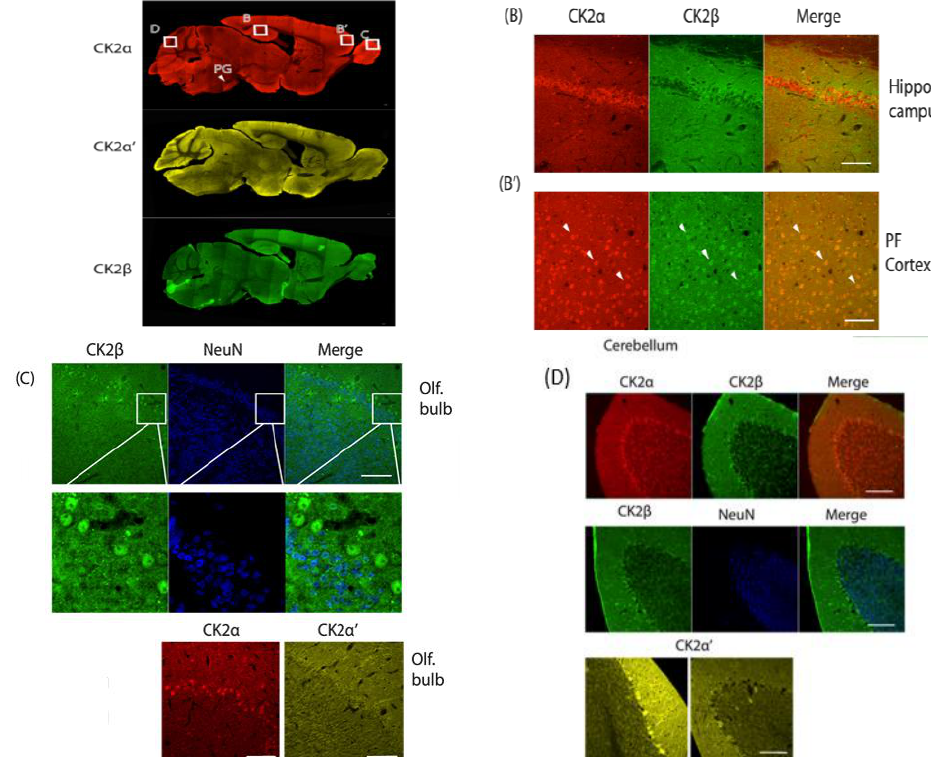
Figure 1. A–D: Immunohistochemical analysis of sagittal brain slices of adult C57BL/6 mice. PFA perfused brains were sliced (40 µm) and incubated with α-CK2α, α-CK2α’ (both Abcam), α-CK2β (gift from Dr. O. Filhol Grenoble) and α-NeuN (Cell Signaling) followed by incubation with secondary antibodies, Alexa 546/488 α-rabbit/α-mouse (Fisher Scientific). Imaging was performed using a Zeiss LSM710 laser-scanning confocal microscope. Slices were stained for CK2α, CK2α’ and CK2β ( A ), the hippocampal CA1region and PFC were stained for CK2α and CK2β ( B ). Olfactory bulb was stained for CK2β and NeuN, CK2α and CK2α’. ( C ) Cerebellum was stained for CK2α, CK2 β and NeuN ( D ) and for CK2α’. PG: Pontine gray nucleus; white bars = 100 µM.